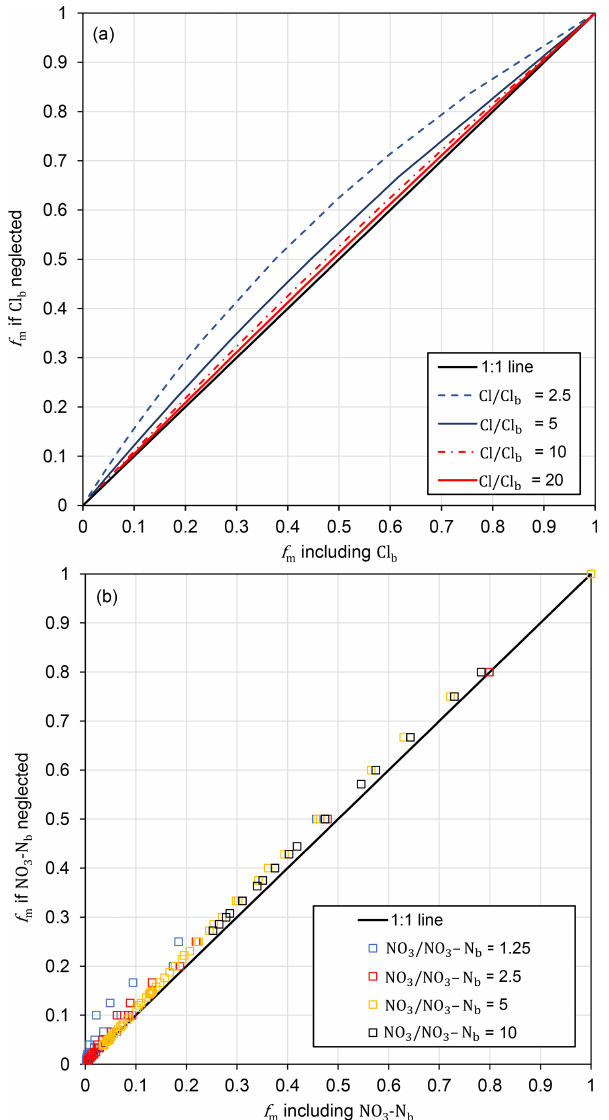
Figure 9. Effect of neglecting background concentrations (Cl b or NO 3 − N b ) in the mixing model on calculated f m over the range of values in this